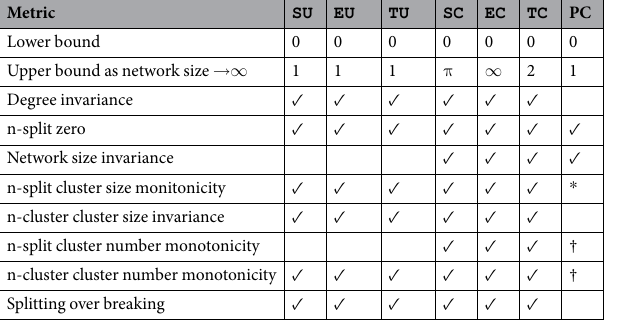
Table 1. A list of desirable properties satisfied by each of the algorithms. ✓ Indicates satisfying the property. Numeric values are listed where relevant. * Denotes trivially satisfying the monotonicity properties by being constant functions. † Denotes that participation coefficient trivially satisfies certain properties due to the lack of degree invariance. Upper bounds were found analytically (see Supplementary